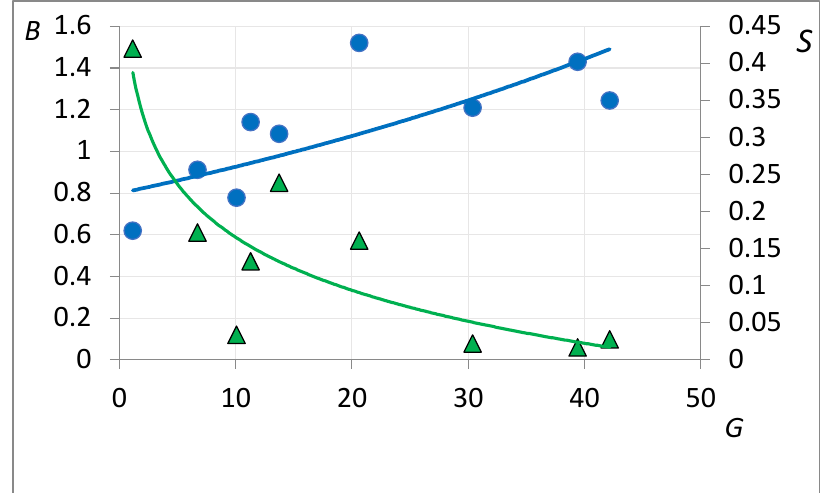
Figure 4. The results of statistical processing of the correlation between the specific incremental production in producers responding to gelling agents injection and the CC coefficient (blue dots and trend) and injectivity drop (green dots and trend).